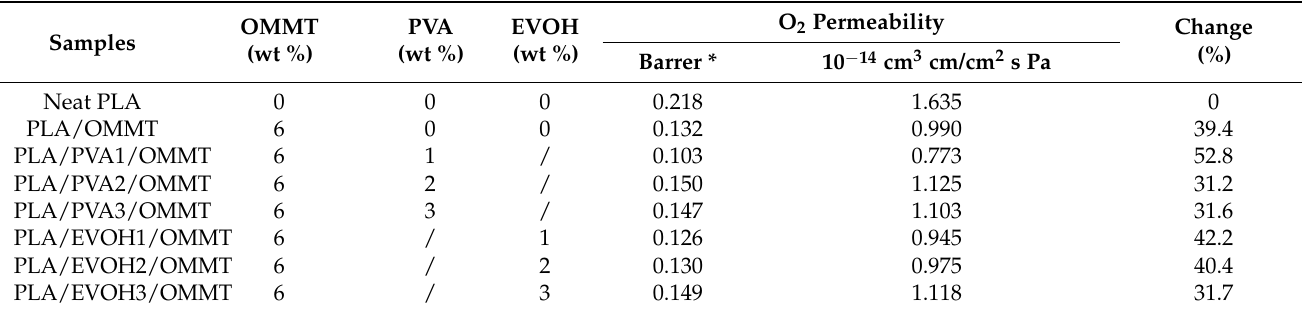
Table 4. The results of oxygen permeability and permeability reduction of the PLA/PVA/OMMT and PLA/EVOH/OMMT